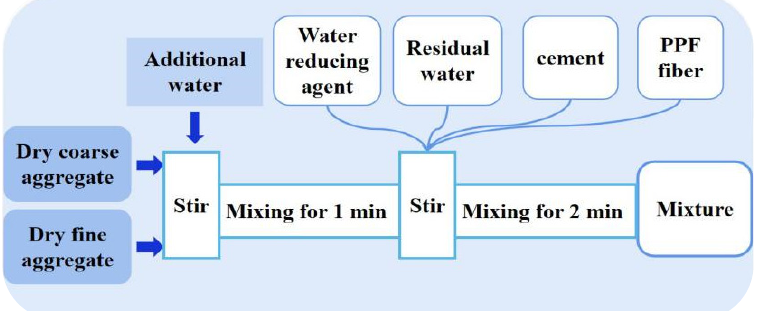
Figure 3. Dosing sequence diagram. Table 5. Specimen design parameters.